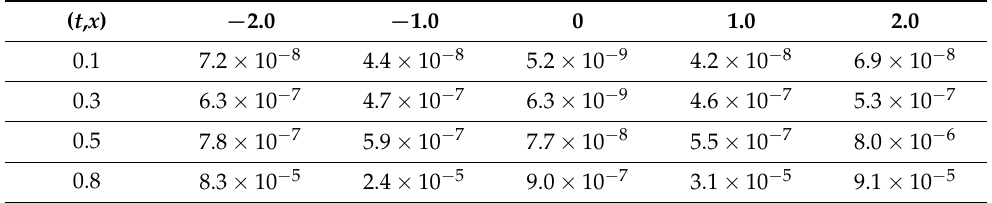
Table 4. Case D: Absolute error for different values of ( x , t ) considering N = 15